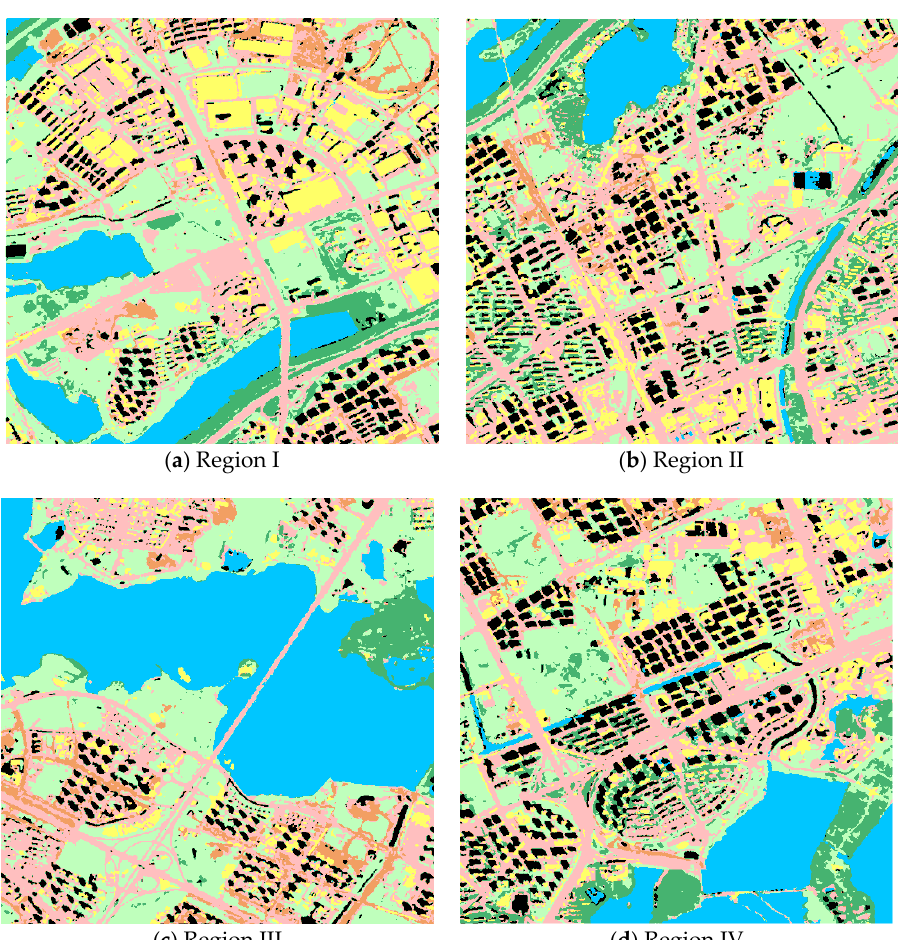
Figure 7. Classification maps of the four test regions provided by the approach that used roads as